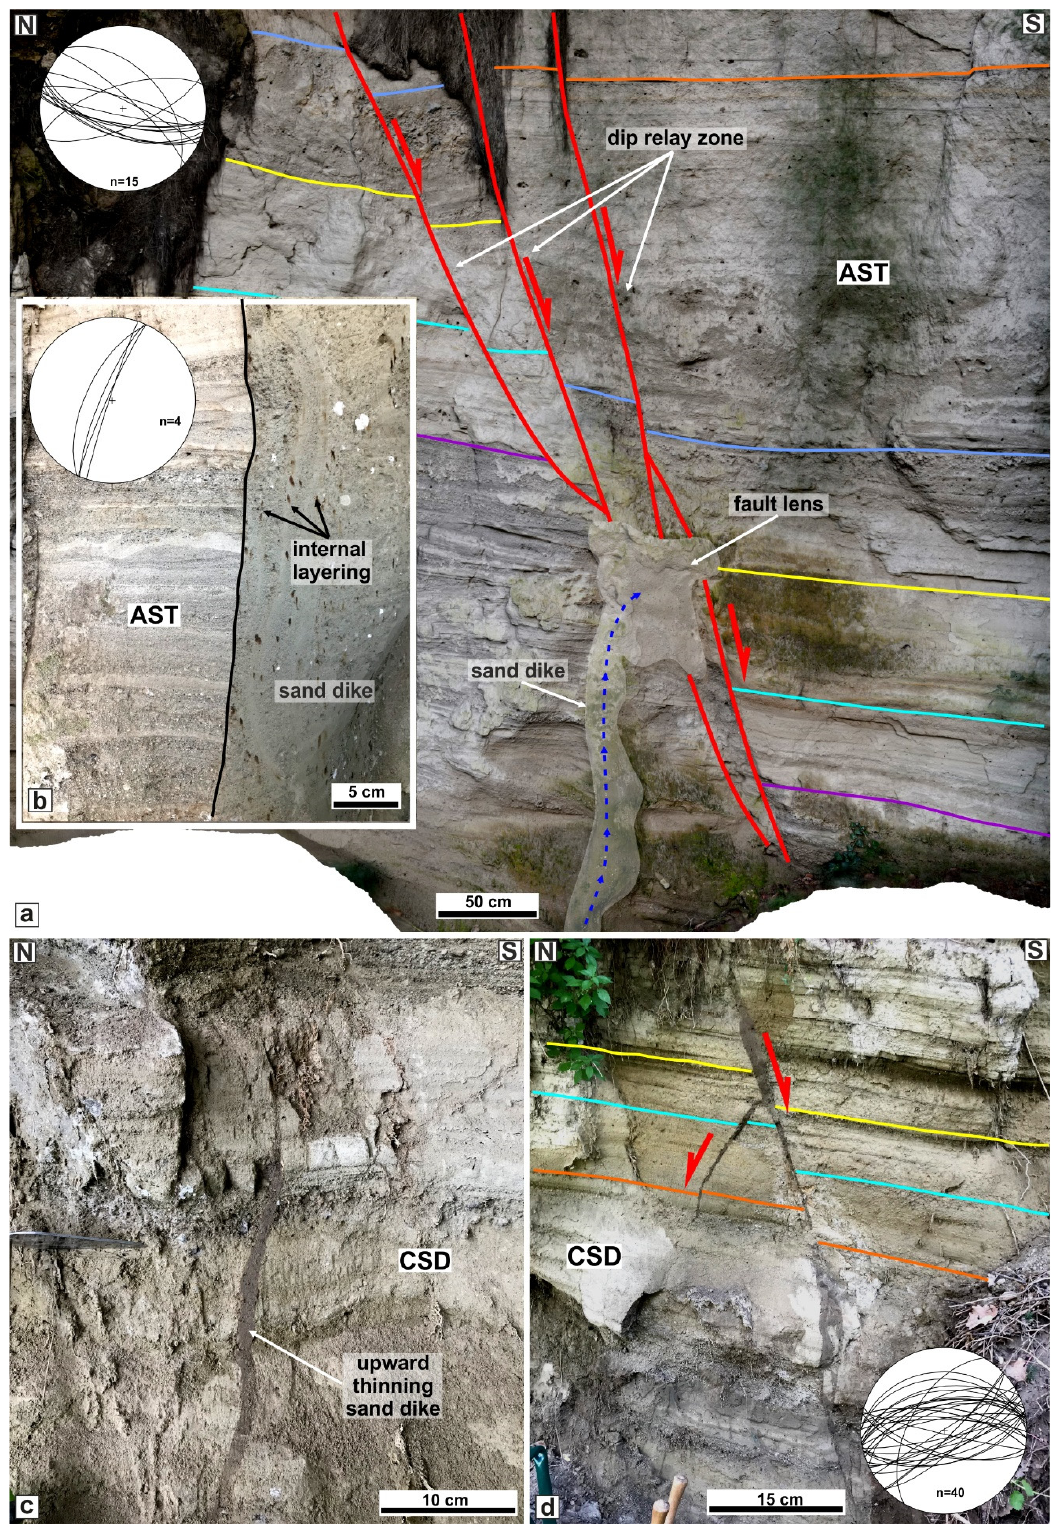
Figure 4. Cupa Cigliano (site 2): ( a ) ~E-W normal fault cross-cutting Astroni (AST) tephra and the sand dike, and stereographic projection of fault planes; ( b ) view along the strike of the sand dike; ( c ) Terme Agnano (site 3): sand dike thinning upward within the Costa San Domenico (CSD) tephra; ( d ) EW conjugate normal faults with associated sand injections in the footwall, and stereographic projection of fault planes.